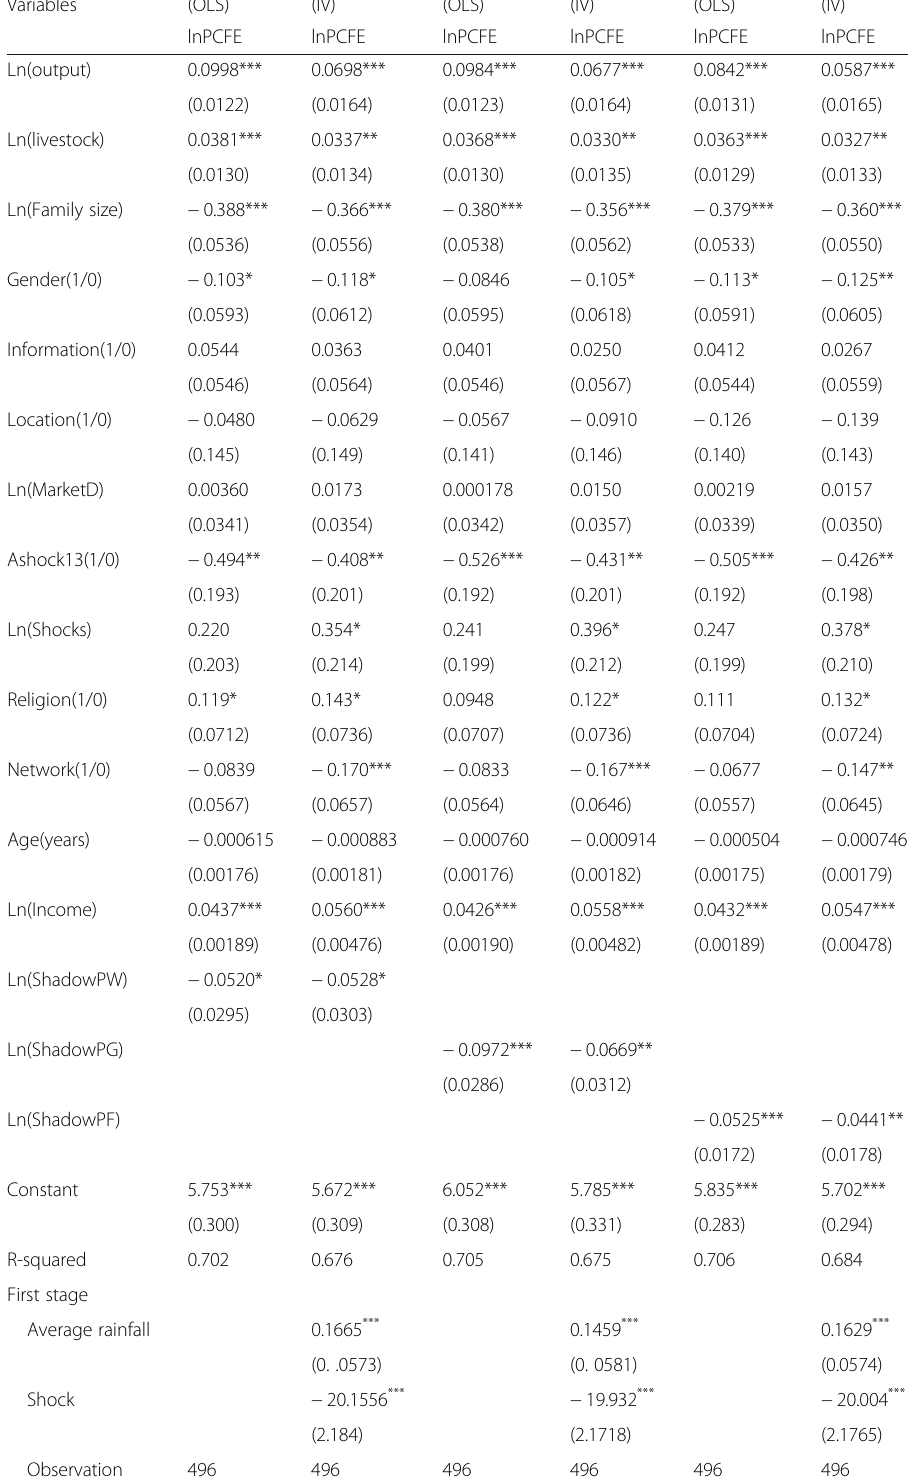
Table 4 IV estimation of log per capita food expenditure using shadow